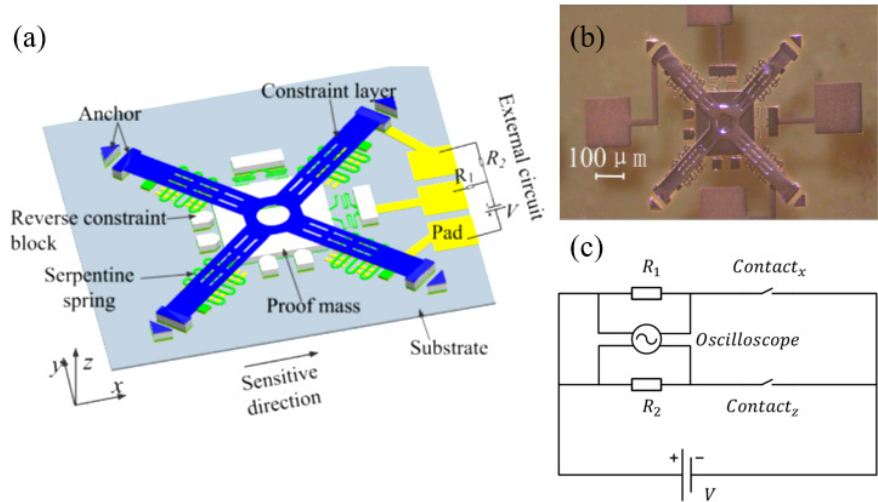
Figure 2. The tri-axial MEMS inertial switch with shock-resistibility (Xu 2016 [83]): ( a ) the working principle; ( b ) the photo; ( c ) the schematic of the test circuit.